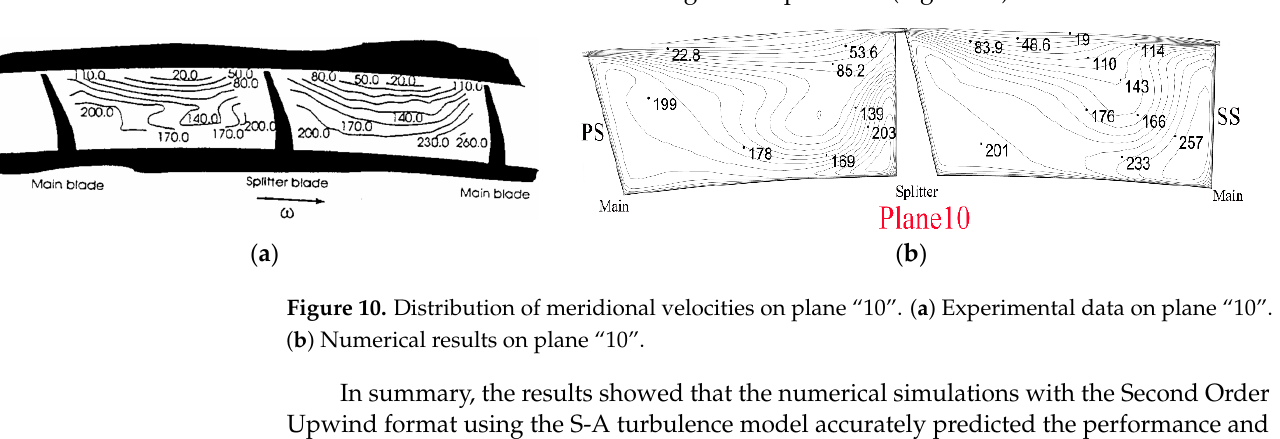
Figure 9. The relative Mach number distribution on the different planes. ( a ) Experimental data on plane “ − 1”. ( b ) Numerical results on plane “ − 1”. ( c ) Experimental data on plane “4”. ( d ) Numerical results on plane “4”. ( e ) Experimental data on plane “10”. ( f ) Numerical results on plane “10”.